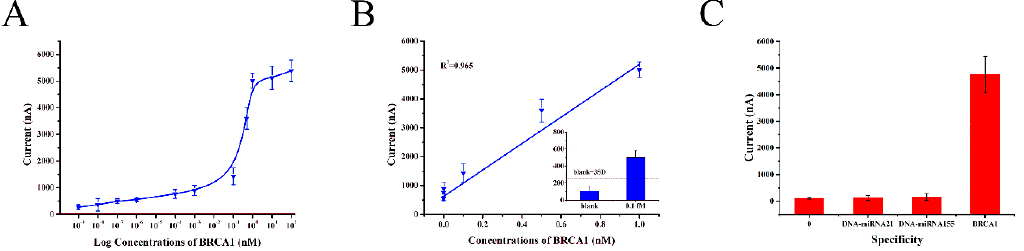
Figure 5. ( A ) The plots of currents versus the target DNA (BRCA1) concentrations: 0, 1 aM, 10 aM, 100 aM, 1 fM, 100 fM, 1 pM, 100 pM, 500 pM, 1 nM, 10 nM, 100 nM. ( B ) The linear calibration curve for BRCA1 detection with the concentrations of 1 fM, 100 fM, 1 pM, 100 pM, 500 pM and 1 nM. Inset: Histogram showing the limit of detection of BRCA1 detection by the electrochemical DNA sensor, and the dashed lines stand for the threshold (blank + 3SD). ( C ) Specificity of the proposed electrochemical DNA sensor. The concentrations of DNA-miRNA21 and DNA-miRNA155 are 1 μ M while the BRCA1 is 1 nM. Error bars show the standard deviations ( n = 4).